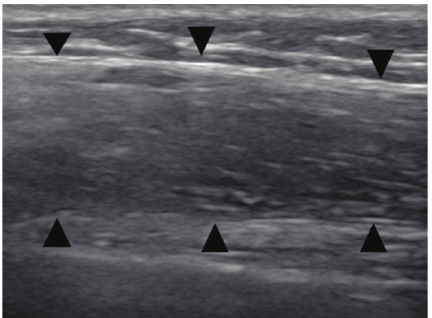
Figure 8: Case 2. Thoracic ultrasonography at the level of the middle third of left thorax shows a thick hypoechoic band with fine echoes, reflecting thickening of the visceral pleura (arrowheads).